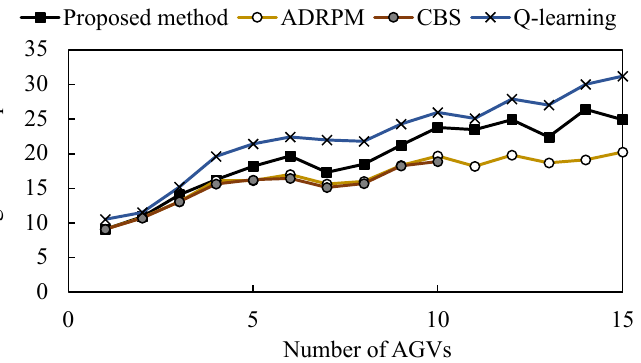
Figure 10. Comparison of total transfer period on static problems. The computation time was measured when the AGV was increased by one unit. For each number of AGVs, 10 initial conditions were prepared, and the average values are shown for each of the 10 experiments conducted under each condition.